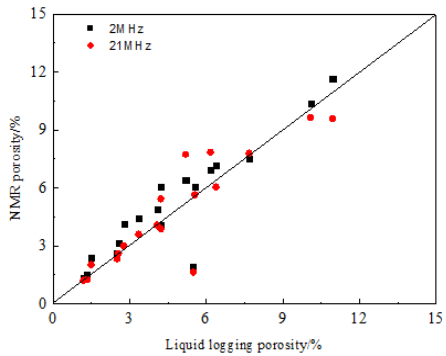
Figure 4. Liquid logging porosity vs. NMR porosityore samples of shale.